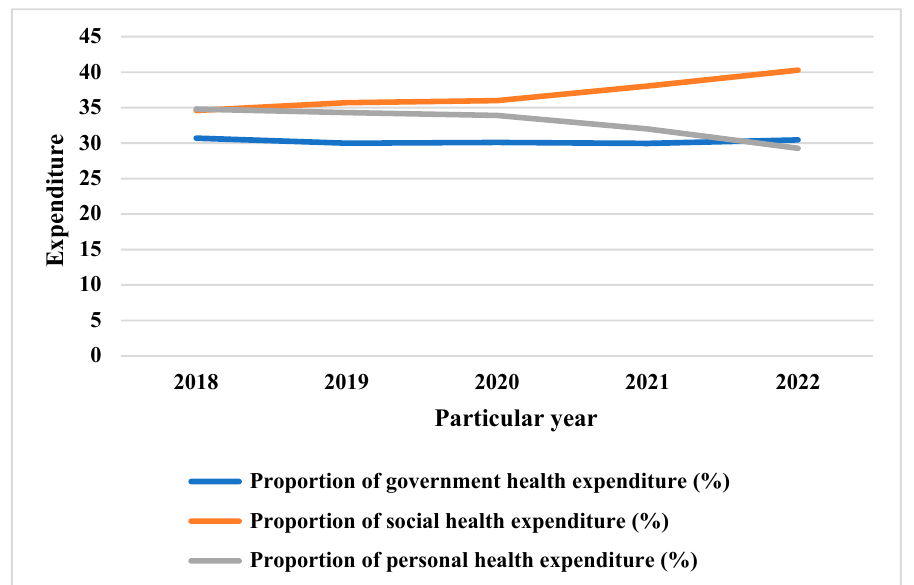
Figure 2. Main structure of public health expenditure in China.